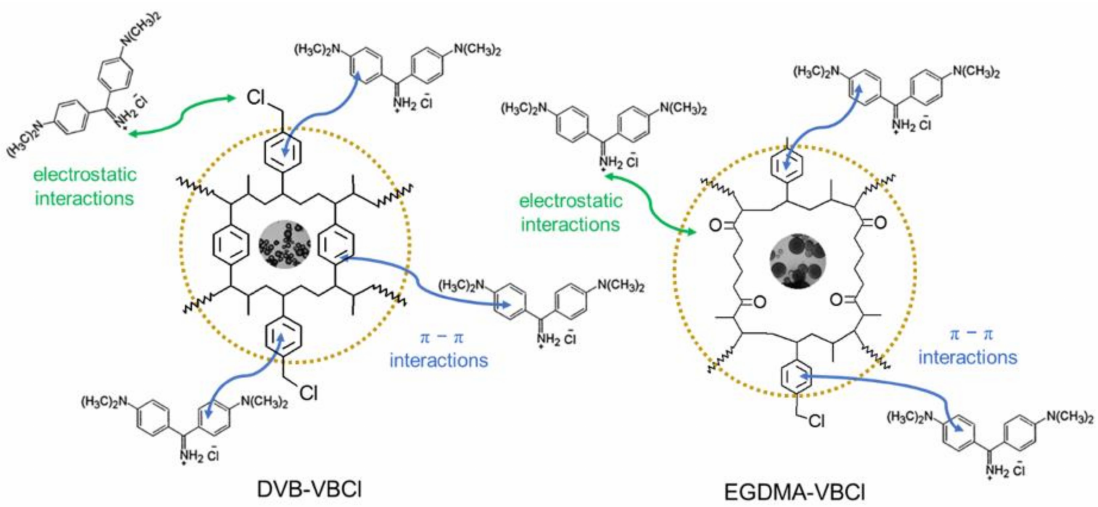
Figure 7. Proposed mechanism of interactions between AO dye and the DVB-VBCl and EGDMA- VBCl